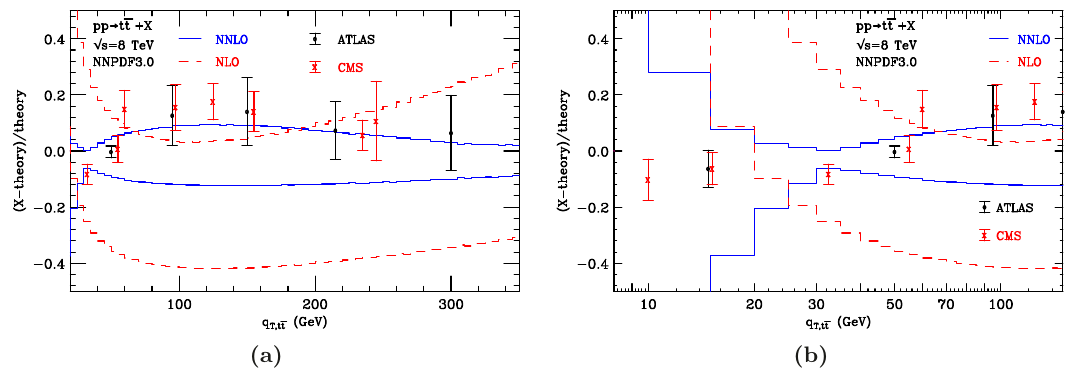
Figure 3. Fractional difference of NLO predictions (red dashed), NNLO predictions (blue solid) and LHC data [17, 18] with respect to the NNLO result at µ F = µ R = m t . The results refer to the normalized q T distribution 1 /σ ( dσ/dq T ) of t ¯ t pairs at √ s = 8 TeV. The two panels highlight (a) the intermediate and large q T region and (b) the small- q T